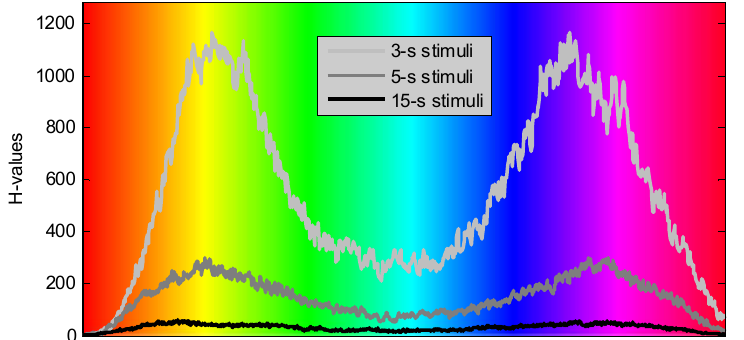
Figure 12. H-values evaluated for the male participants and for all EEG channels as functions of stimulation color.